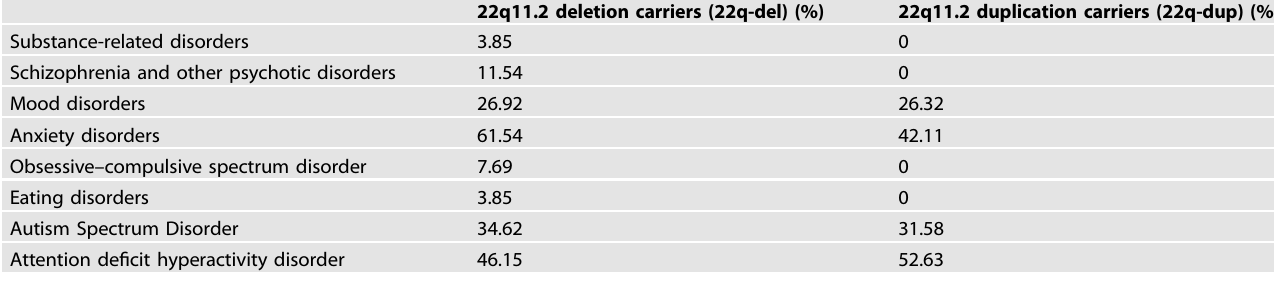
Table 2. Psychiatric diagnoses in CNV carriers*.